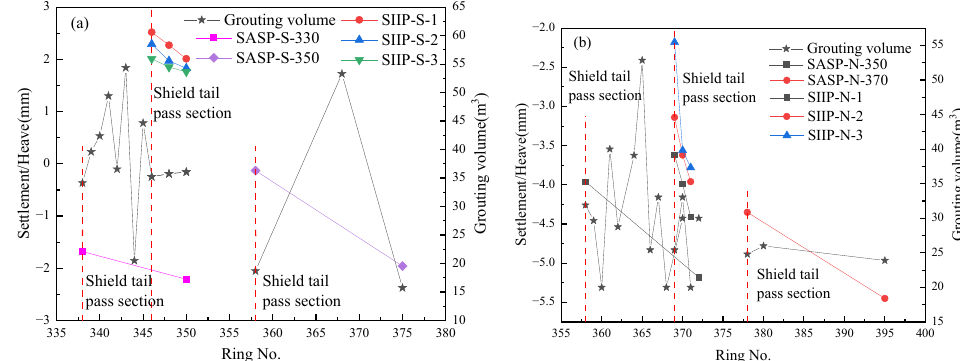
Figure 20. Relationship between surface deformation and grouting volume: ( a ) south line; ( b ) north line.